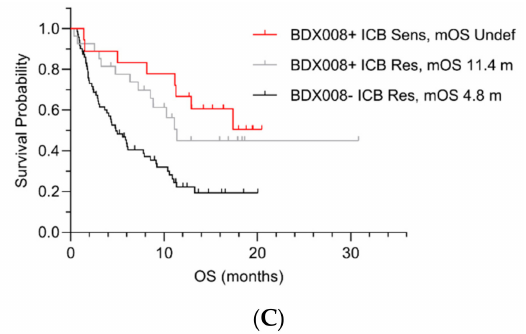
Figure 1. OS by pairwise test classifications in the lung cancer development set by ICB and PIR ( A ), BDX008 and PIR ( B ), and BDX008 and ICB ( C ). Sens = Sensitive; Res = Resistant; NotRes = Not Resistant; mOS = median OS; m =